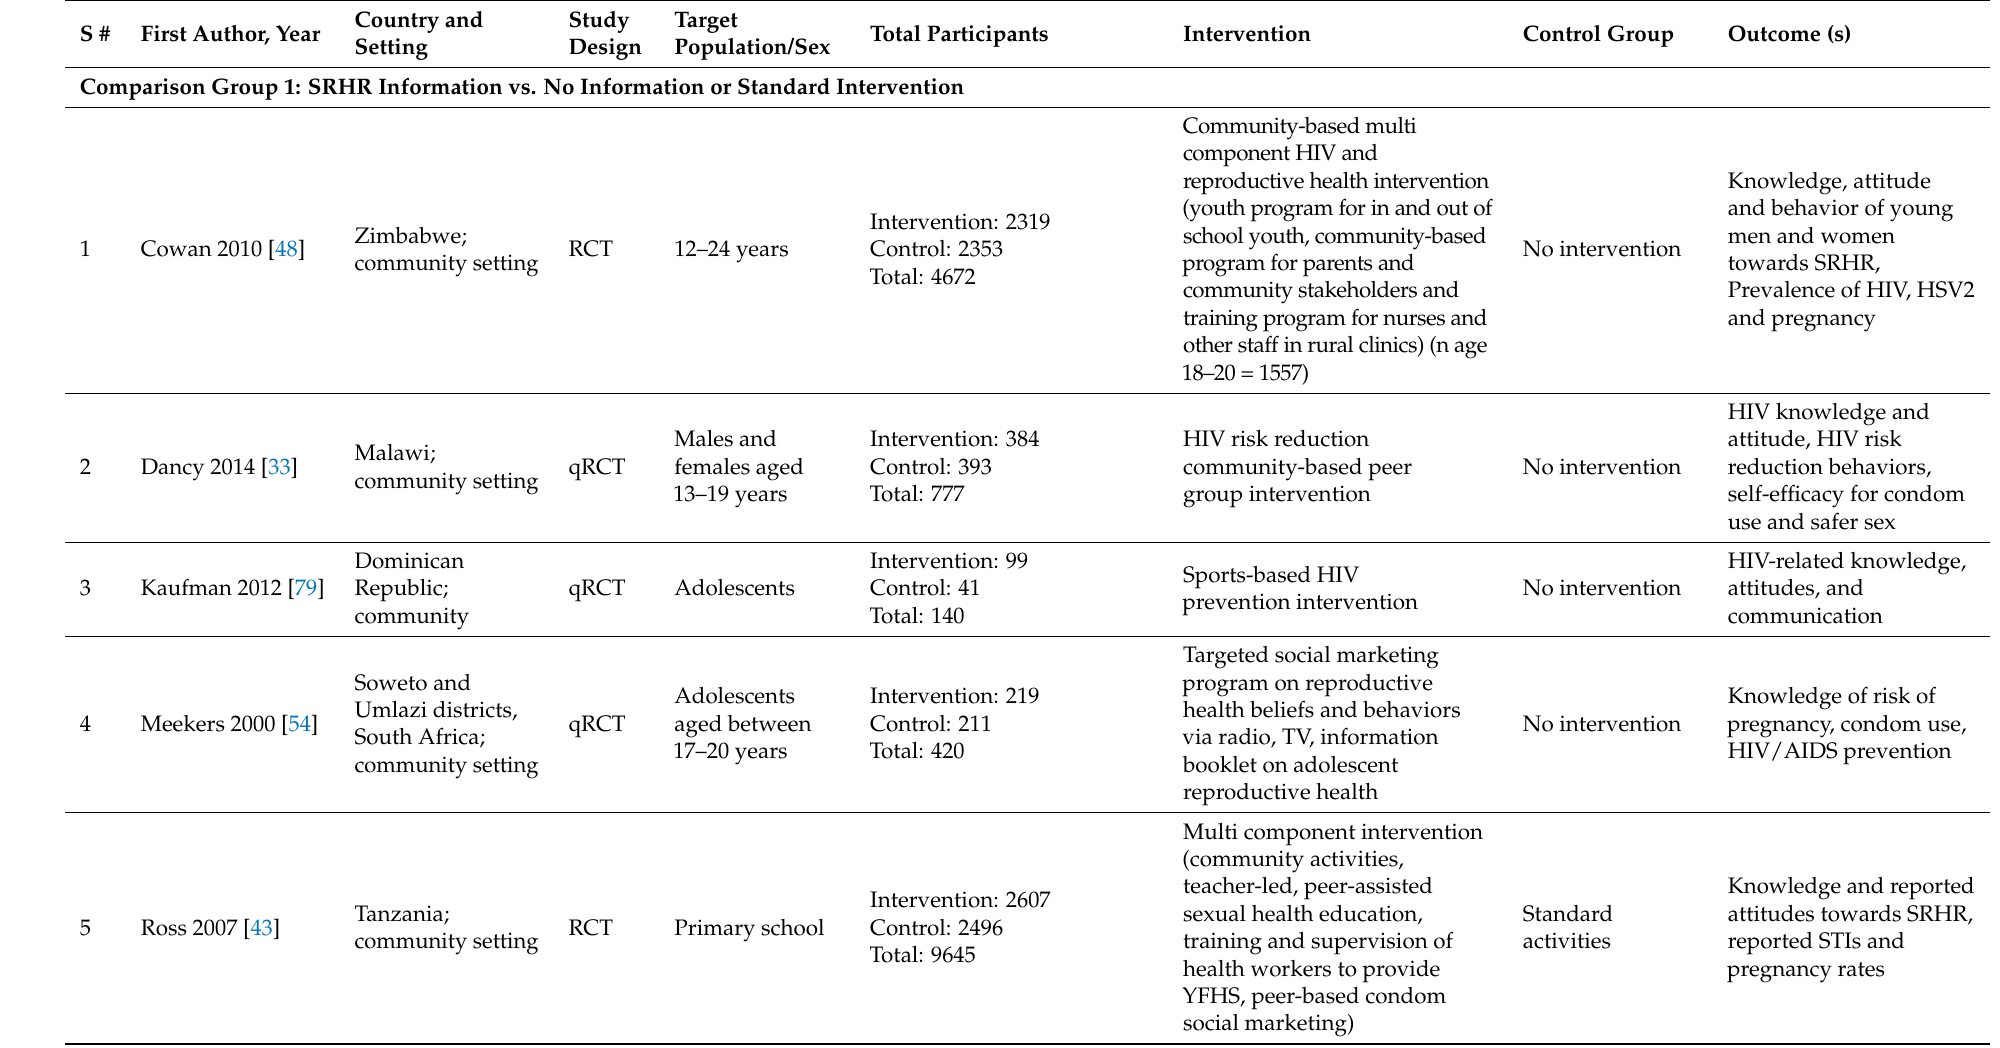
Table 1. Characteristics of included